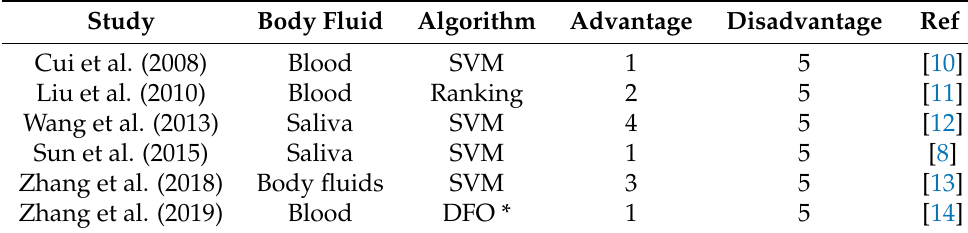
Table 1. Existing studies for predicting secretory